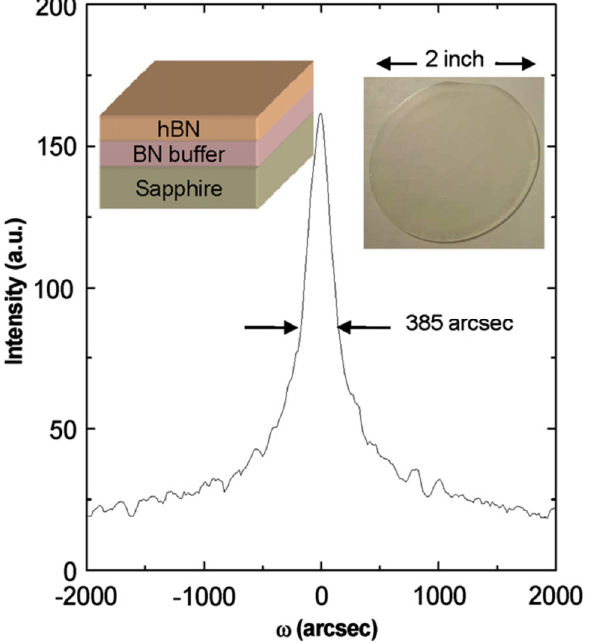
Figure 3. Angular scan to find out FWHM (the image is reproduced from [31], copyright 2011, with permission from Elsevier).